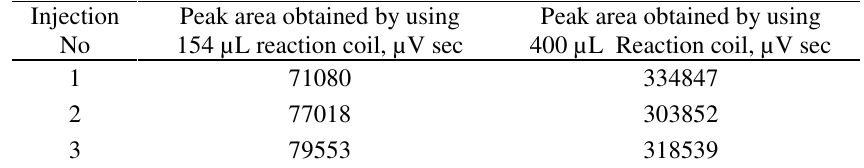
Table 2. Peak area of 100 µg/L bromate standard solution using different reaction